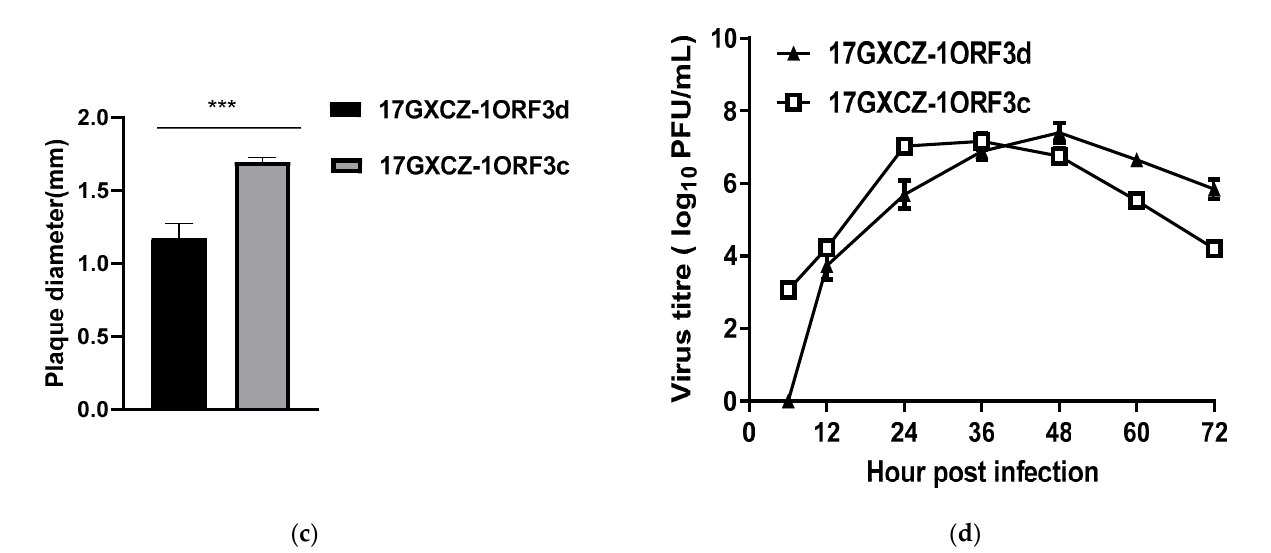
Figure 2. Plaque purification and viral growth kinetics of the PEDV strains 17GXCZ-1ORF3d and 17GXCZ-1ORF3c. Plaque purification of the PEDV strains ( a ) 17GXCZ-1ORF3d and ( b ) 17GXCZ-1ORF3c. Vero cell monolayers were inoculated with 10-fold serially diluted PEDV strains of 17GXCZ-1ORF3d and 17GXCZ-1ORF3c, respectively. After incubation for 1 h, the cells were overlaid with 1% agarose. Plaques were stained with crystal violet at 3-4 dpi. ( c ) The plaque diameters of 17GXCZ-1ORF3d and 17GXCZ-1ORF3c. The diameters of ten randomly selected plaques were measure using a ruler in the ImageJ 1.8.0 software. *** represents that the mean diameters of plaques formed by 17GXCZ-1ORF3d (1.18 mm) were significantly smaller than those of 17GXCZ-1ORF3c (1.70 mm), with p values of < 0.001. ( d ) Viral growth kinetics of 17GXCZ-1ORF3d and 17GXCZ-1ORF3c in Vero cells. Vero cells were inoculated with the 17GXCZ-1ORF3d and 17GXCZ-1ORF3c strains at MOI = 0.001, respectively. The infected cells were collected at 6, 12, 24, 48, 60 and 72 hpi for virus titrations. The virus titers at each time point were determined in triplicate using plaque assays.